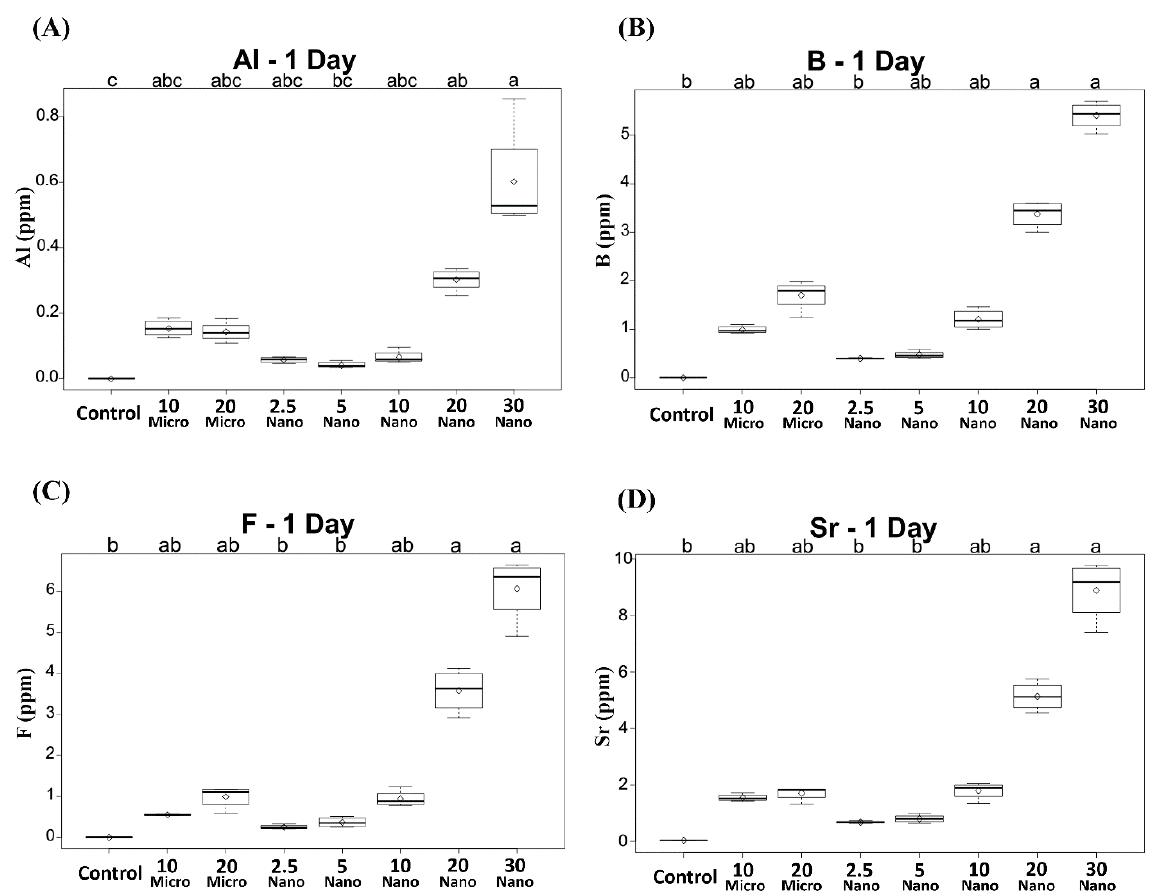
Figure 2. Concentrations of ( A ) Al, ( B ) B, ( C ) F, and ( D ) Sr ions released after 1 day from tissue conditioners incorporating different ratios of S-PRG filler and the control. Different letters above the boxplots indicate statistically significant differ- ences.